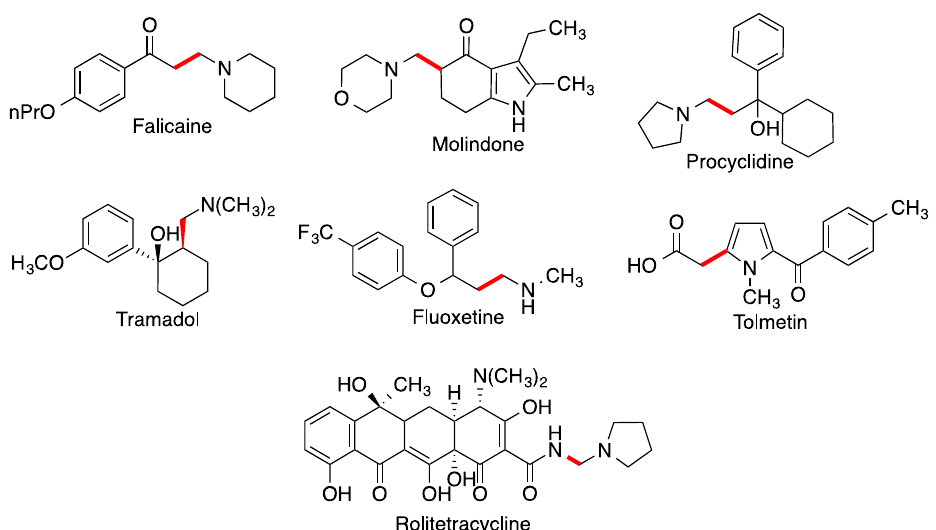
Figure 1. Some drugs that are synthesised using a Mannich reaction as the key step. The bond thus created is marked in